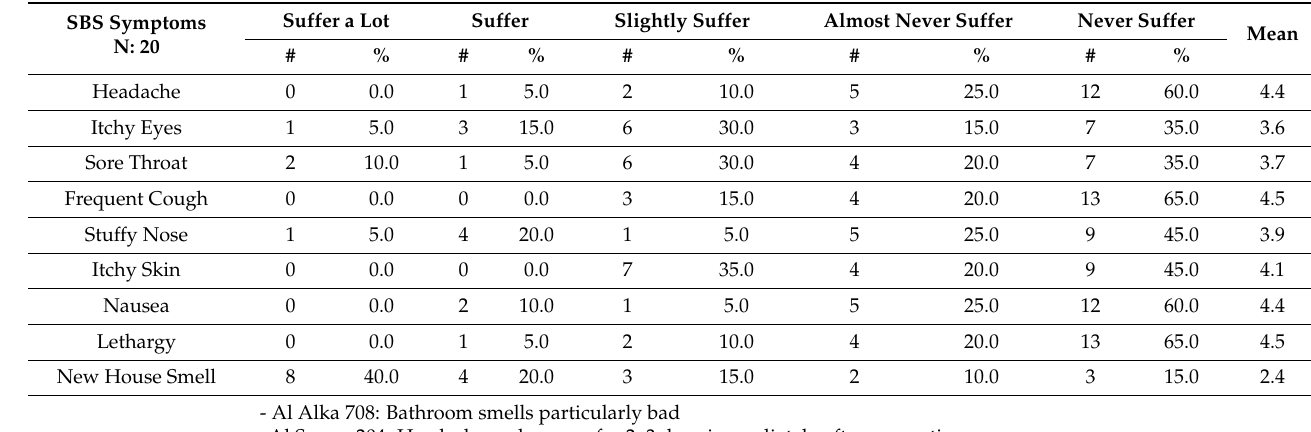
Table 7. Sick Building Syndrome (SBS) symptoms immediately after renovation.